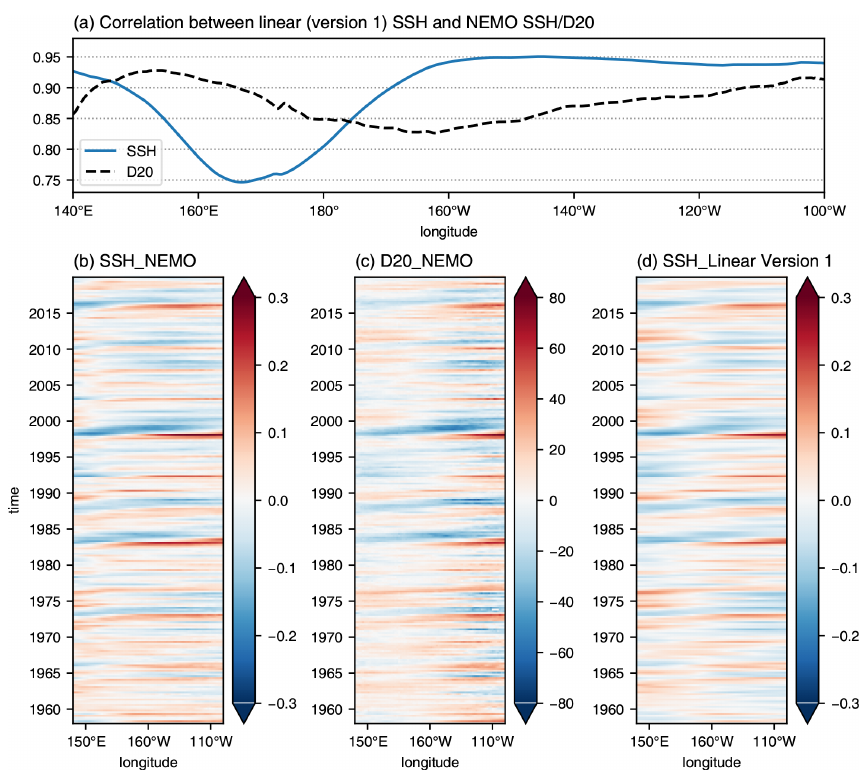
Figure 6. (a) The correlation between SSH from Version 1 of the linear model and anomalies of SSH (blue) and D20 from the NEMO model simulation (black dashed). All time series have been detrended and all the correlations shown are significantly different from 0 at the 99% level. Also shown are Hovmöller diagrams (units of metres), along the Equator, of anomalies of (b) SSH and (c) D20 from the NEMO model and (d) SSH from Version 1 of the linear